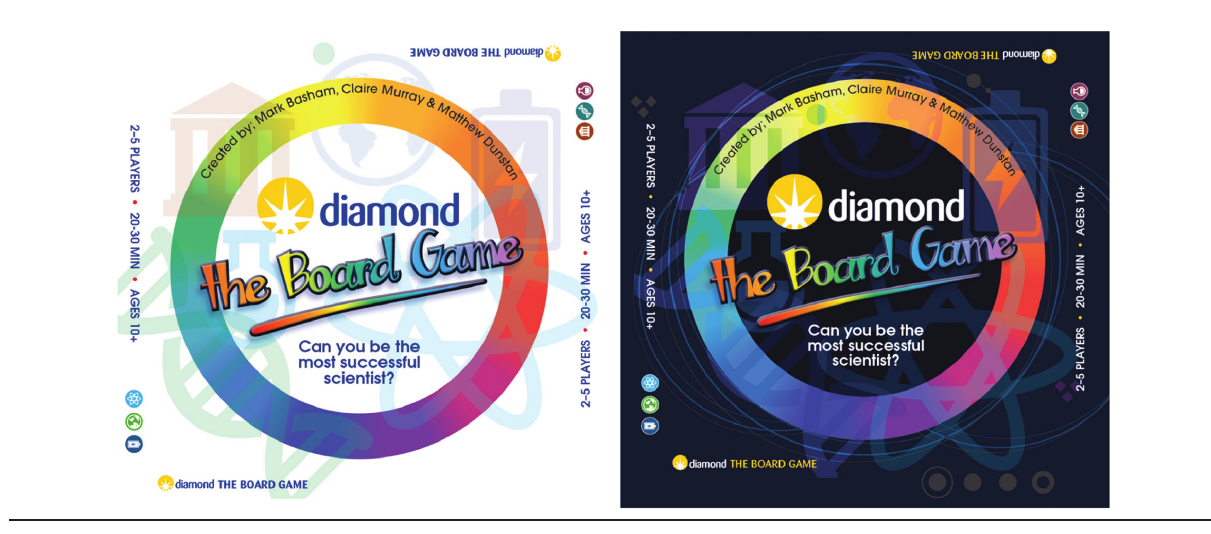
Figure 3. The initial light and dark box designs (Source: Authors, 2022; Diamond Light Source,